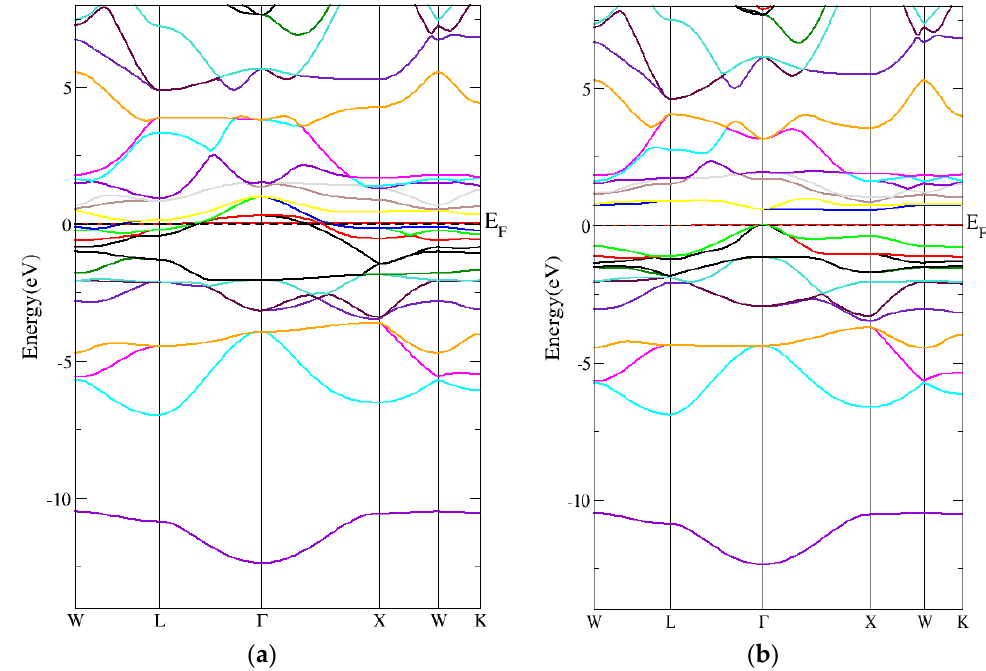
Figure 8. The band structure for the inverse Heusler Cr 2 MnSb compound by employing the PBE- GGA technique for ( a ) spin-up inverse Heusler Cr 2 MnSb compound and ( b ) spin-down inverse Heusler Cr 2 MnSb compound.